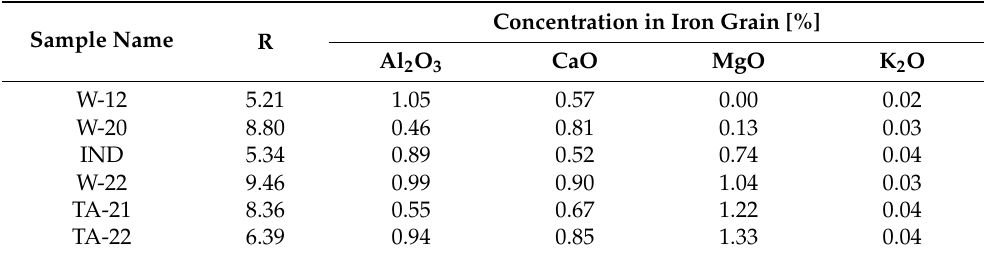
Table 2. Concentration of precursors in iron grains.